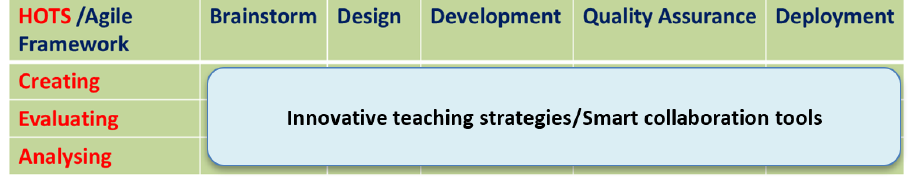
Figure 4. Agile framework mapping for HOTS development using smart classroom tools.